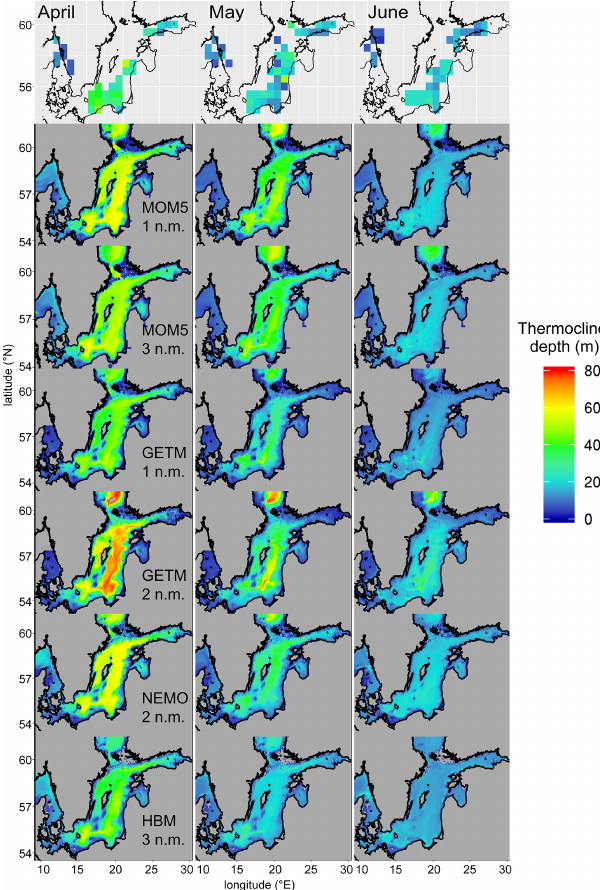
Figure 14. Thermocline depth as derived from ICES observational data (uppermost row) and from different BMIP models. Gray areas in the ICES maps indicate a lack of data, in the BMIP model maps they denote values above 60m. Note, the maps are cut off in the north due to lack of sufficient ICES data for the cline